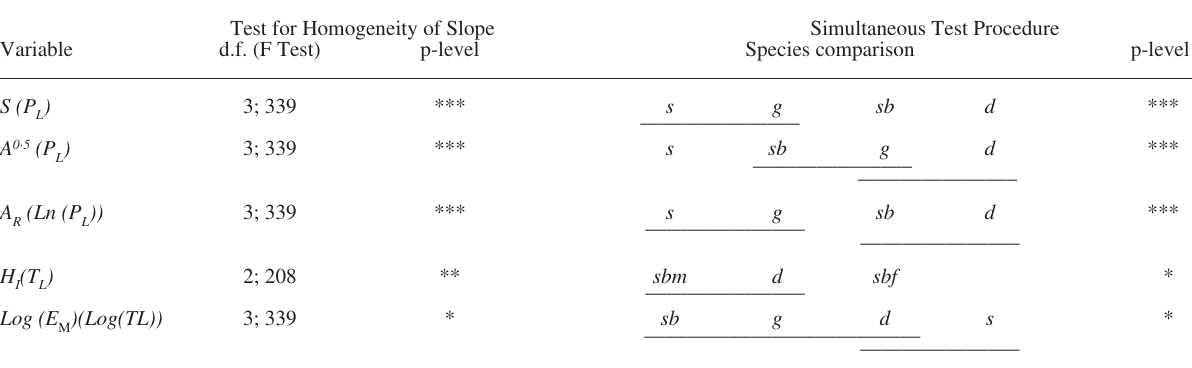
) among Sciliorhinus canicula ( s ), Galeus melastomus ( g ), Squalus blainvillei ( sb , m : total length. Underlined species are not significantly l